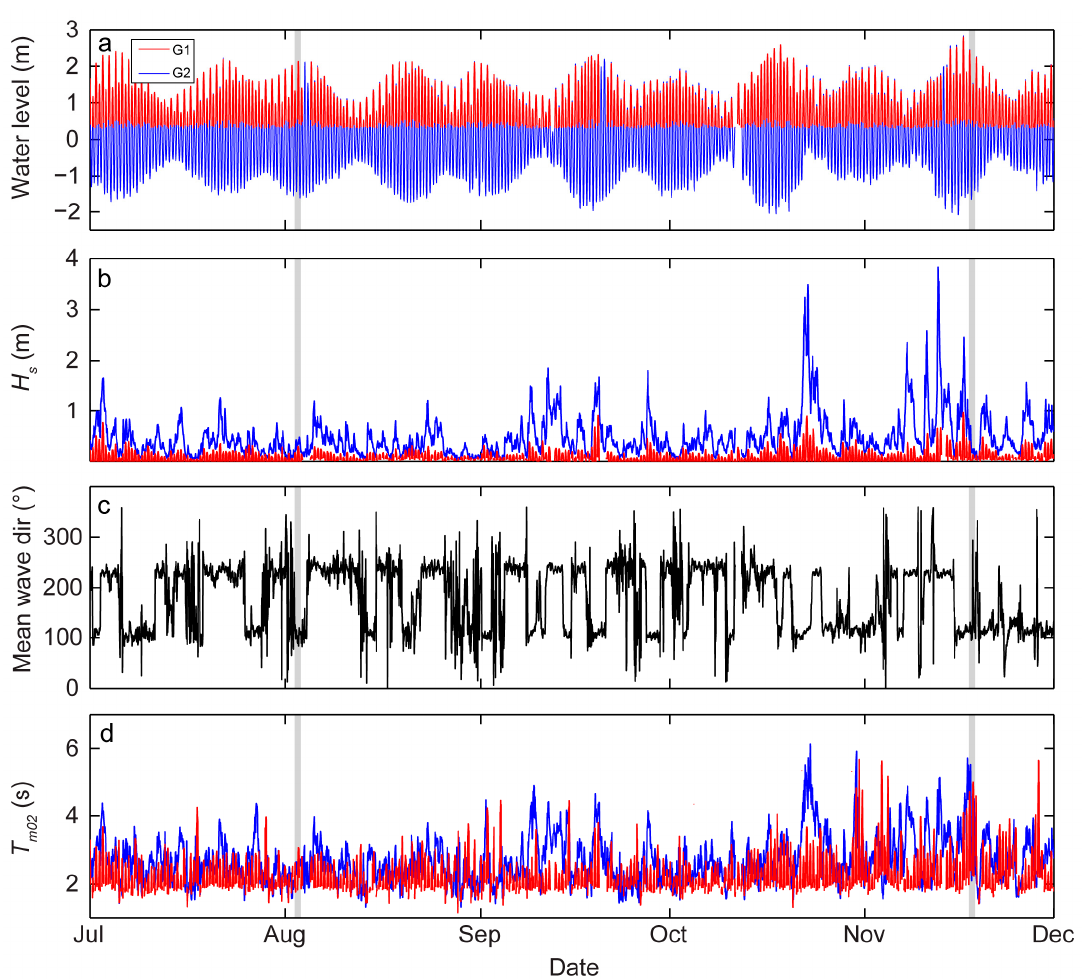
Figure 3. Mean water level (with daily tidal cycles) (m) ( a ), significant wave height (m) ( b ), mean wave direction (°) ( c ), and period (s) ( d ) recorded between July and December 2016. The surveys of 3 August and 18 November 2016 are shown by vertical grey bands.